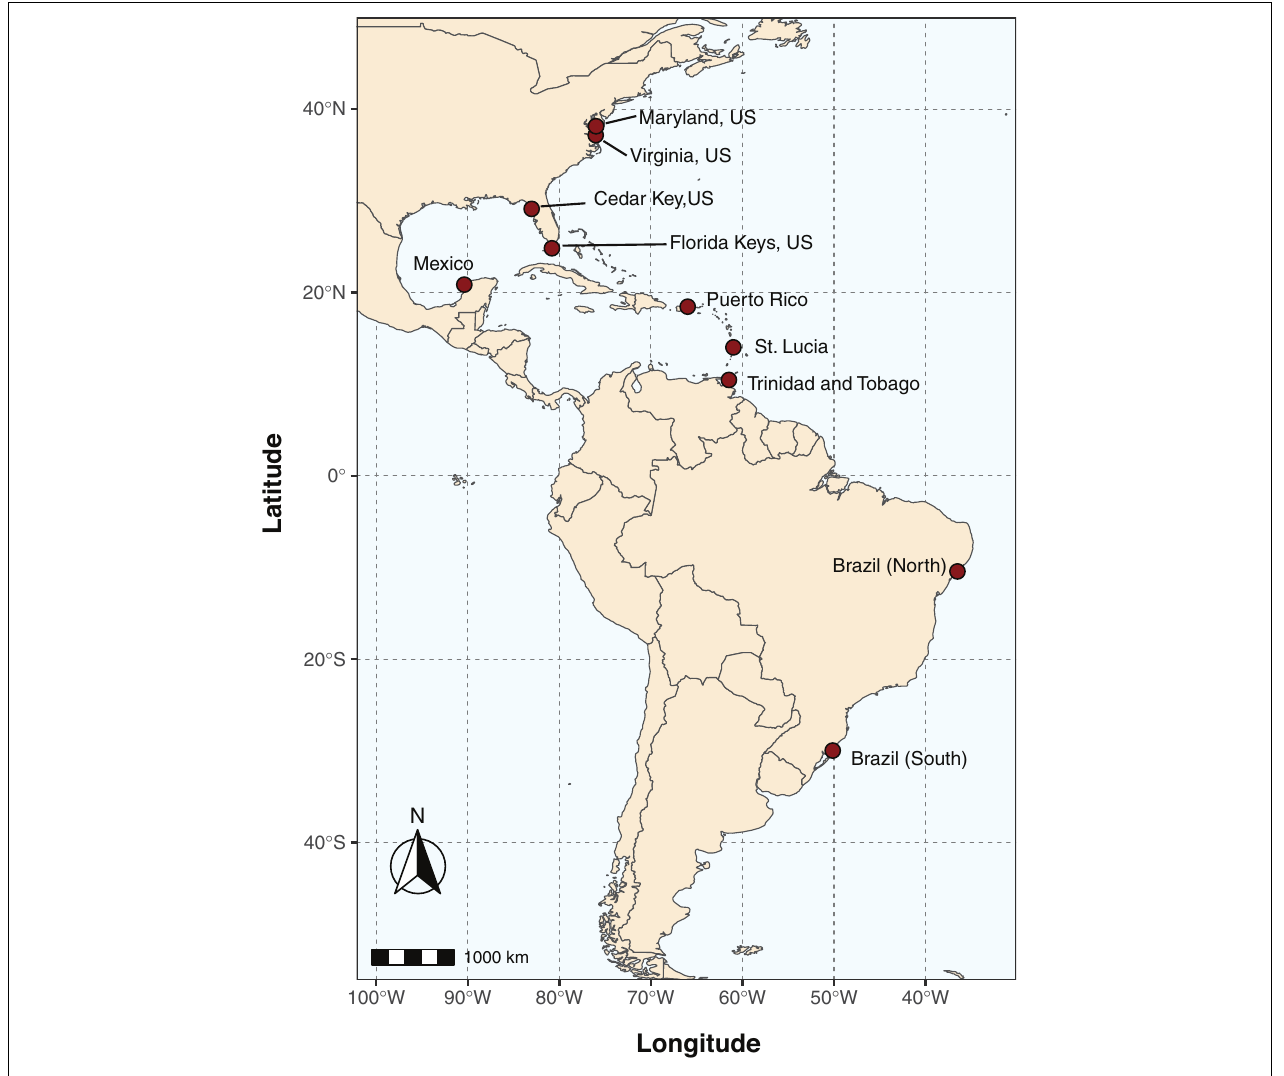
FIGURE 1 | Map of collection locations for Callinectes spp. See Table 1 for sample date, location details, and GPS coordinates at each